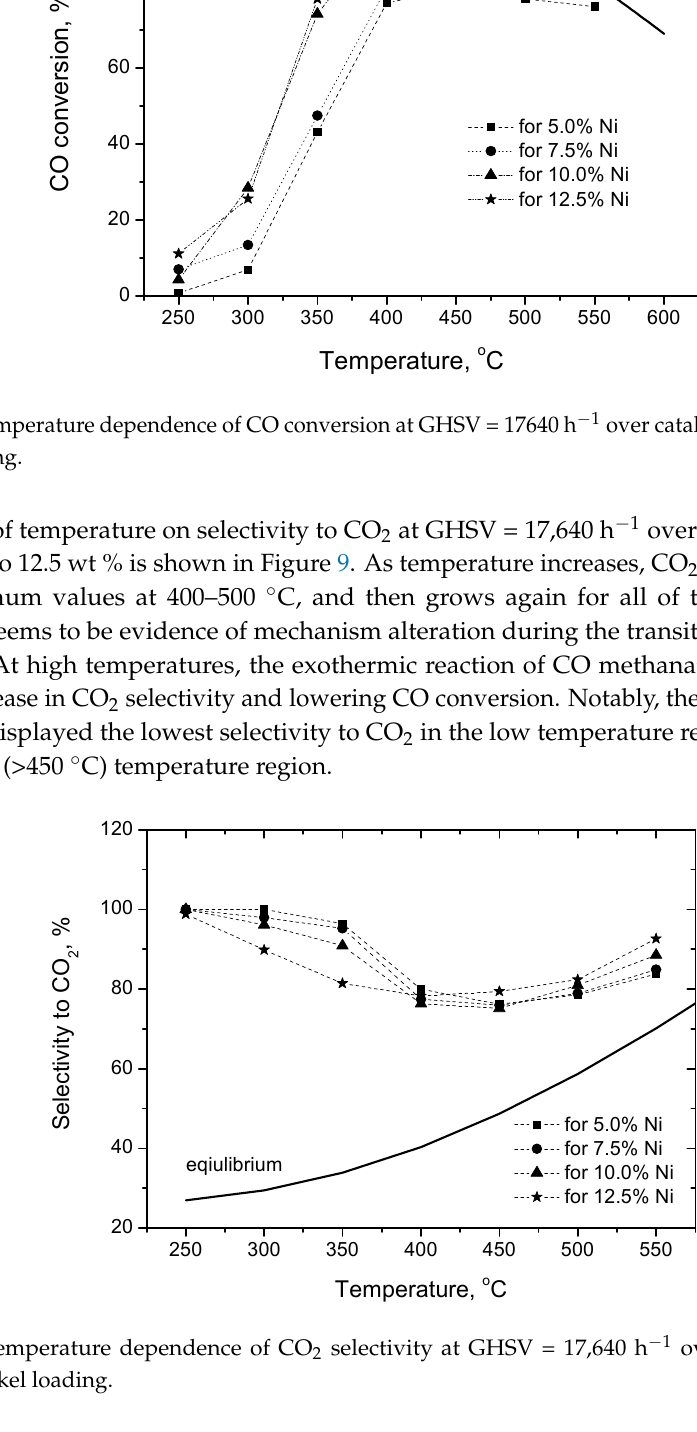
Table 4. Feed characteristics of a four ‐ component mixture. Inlet